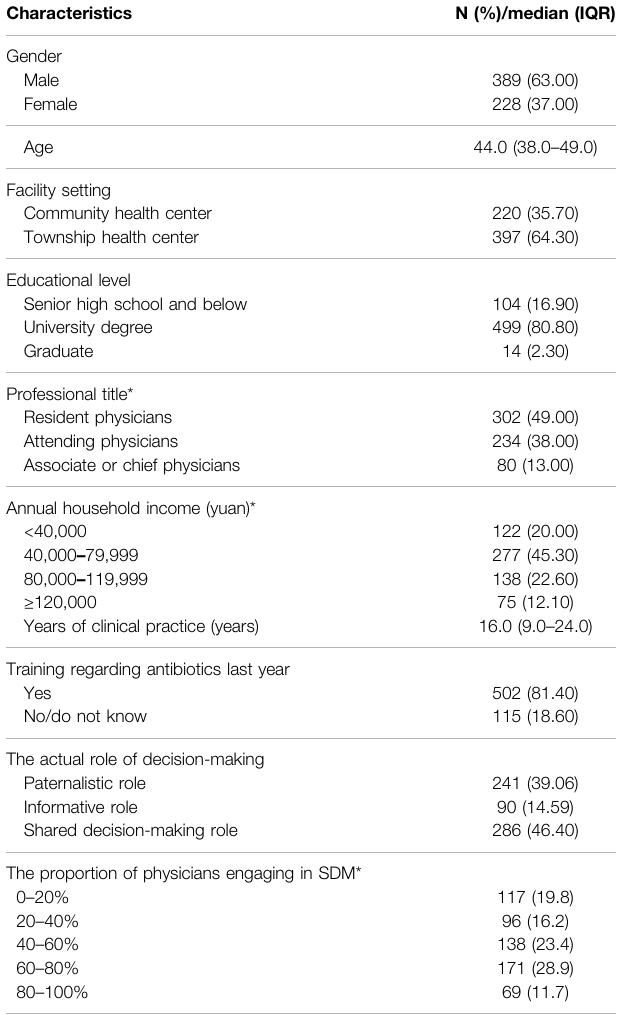
TABLE 2 | Demographic and work characteristics of the physicians ( n = 617)